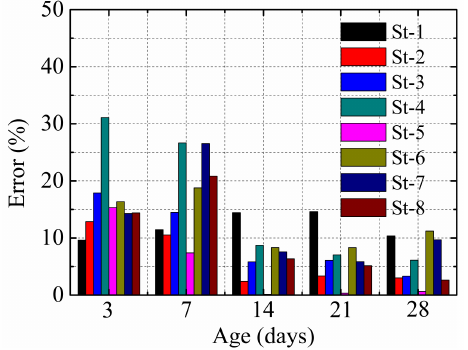
Figure 13. Calculation